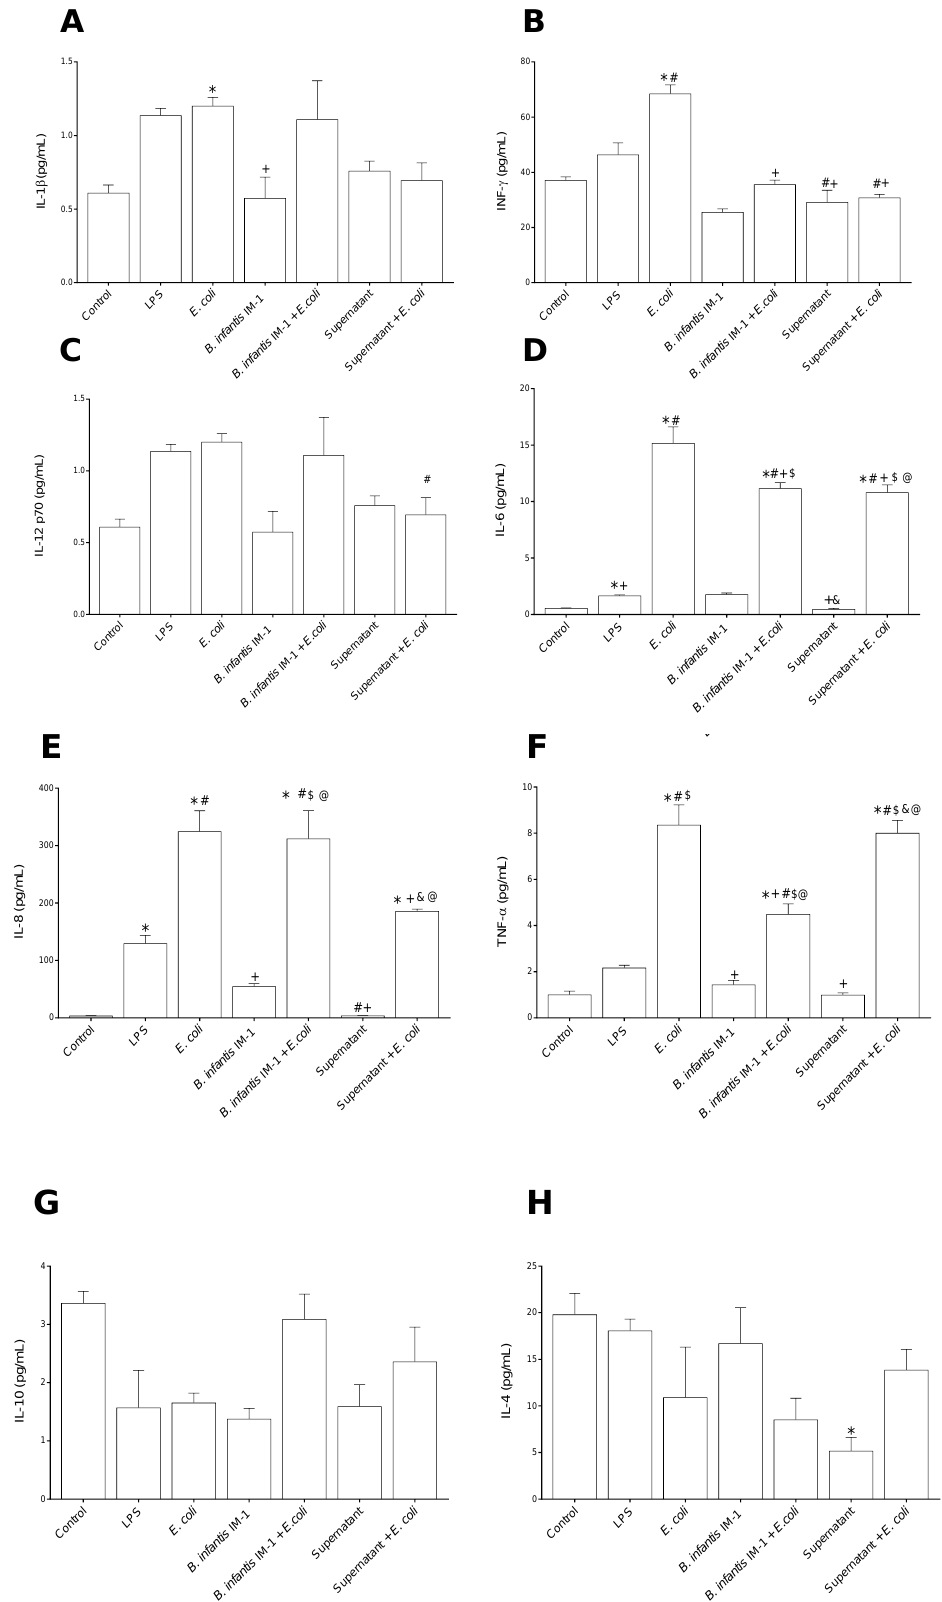
Figure 2. Cytokine levels in the culture medium of Caco-2 cells after 8 h of treatments. ( A ) IL-1 β . ( B ) IFN- γ . ( C ) IL-12 p70. ( D ) IL-6. ( E ) IL-8. ( F ) TNF α . ( G ) IL-10. ( H ) IL-4. Results are expressed in pg/mL as the mean ± SEM of three independent experiments. * p < 0.05 vs. control (untreated cells); # p < 0.05 vs. LPS; + p < 0.05 vs. E. coli ; $ p < 0.01 vs. B. infantis IM-1 ® ; & p < 0.01 vs. B. infantis IM-1 ® + E. coli; @ p < 0.001 vs. supernatant.